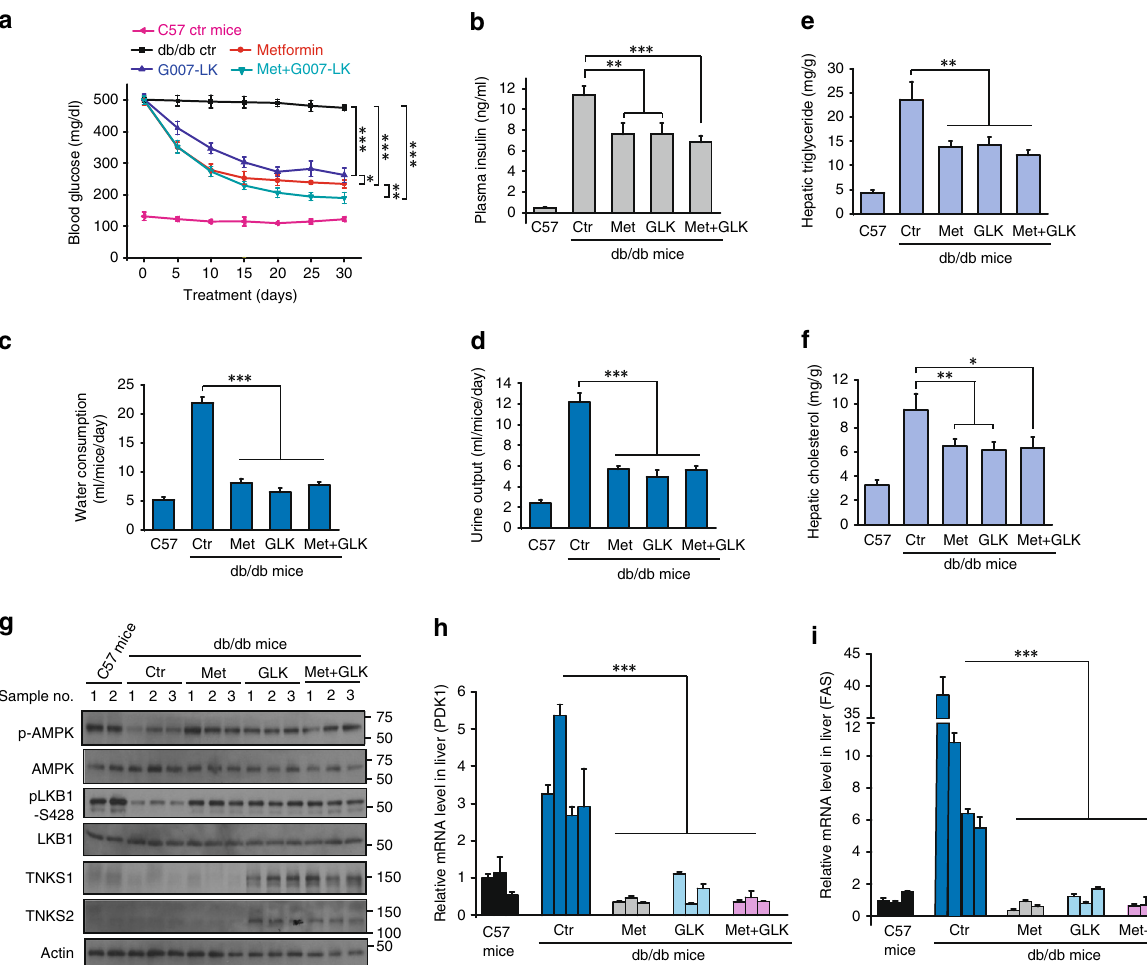
Fig. 5 Tankyrase Inhibitor G007-LK Improves Glycemic Control in a Diabetic Mouse Model. a Tankyrase inhibitor G007-LK lowers blood glucose in db/db mice. The db/db mice were separated into four groups and i.p.-injected with vehicle (PBS), metformin (50 mg/kg), G007-LK (30 mg/kg) or the combination of metformin plus G007-LK daily for 30 days. Blood glucose levels were measured with a glucometer on the indicated days after the mice had been fasted for 18 h. b Basal plasma insulin concentrations were measured in each group at day 30. c , d Daily water consumption ( c ) and urine output ( d ) were measured after 3 weeks of treatment; data are presented as means ± SD ( n = 5 independent experiments for water consumption and n = 3 for urine output). e , f Liver lipids from each group were extracted and hepatic triglyceride ( e ) and cholesterol ( f ) levels were measured. g Liver proteins from the indicated groups of db/db mice were extracted, and phosphorylation levels of AMPK and LKB1 were examined by western blotting. h , i Liver mRNAs from each group were extracted, and relative expression of PDK1 ( h ) and FAS ( i ) were determined by qPCR; transcript levels were determined relative to mRNA levels and normalized. The results represent the means ± SD ( n = 3 independent experiments). Statistical signi fi cance was determined by a two-tailed, unpaired Student ’ s t -test. * P < 0.05; ** P < 0.01; *** P <